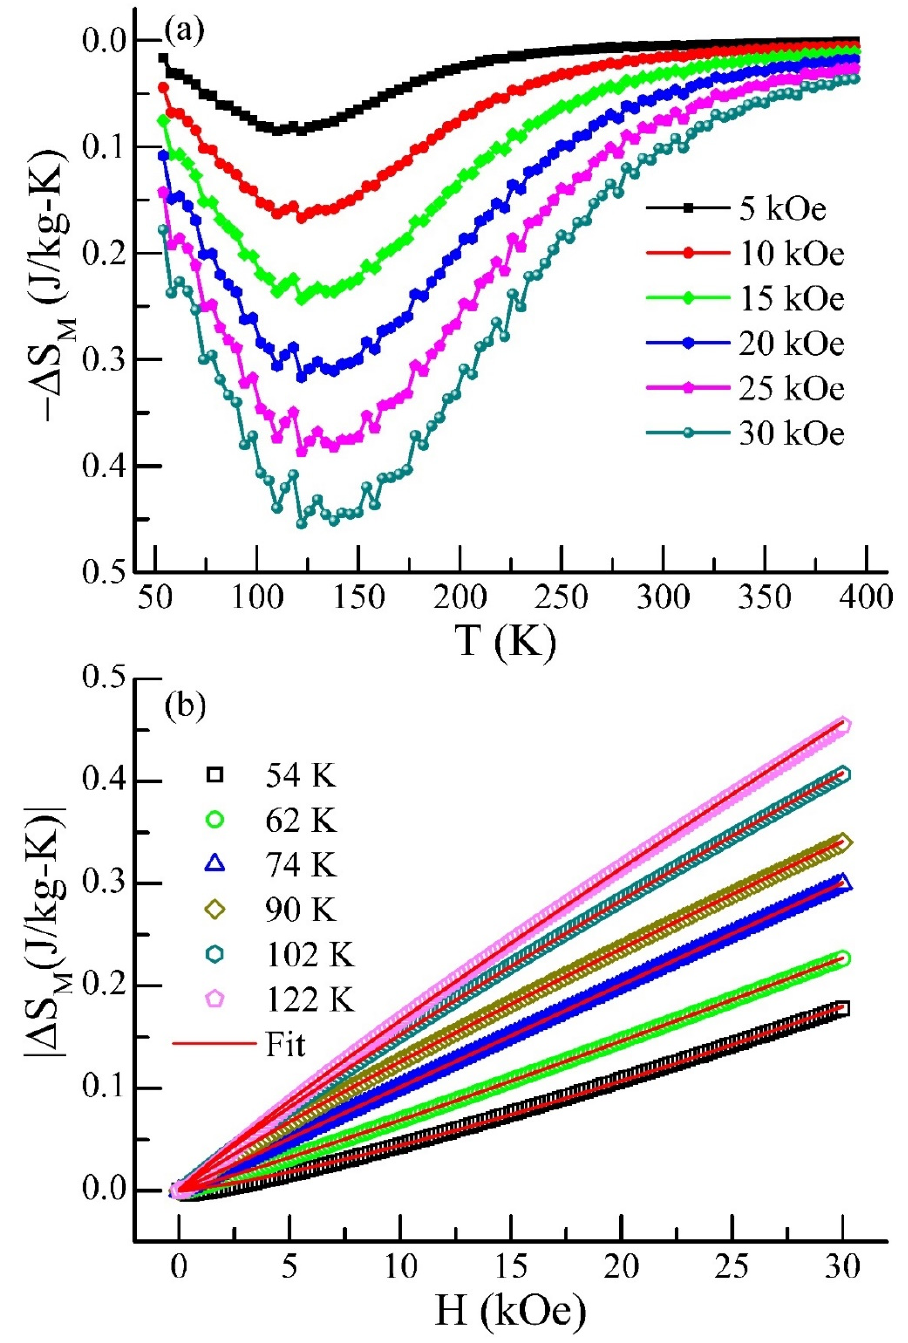
Figure 4. Temperature and applied field-dependent isothermal magnetic entropy change ( ∆ S M ) derived from virgin magnetic isotherms: ( a ) ∆ SM vs. T plot at different applied field changes for Fe 65 Ni 35 . ( b ) ∆ SM vs. H plot with power law fitting ( ∆ S M ~H n ) at different temperatures for Fe 65 Ni 35 . Data and fitting are shown in the symbols and solid lines, respectively.